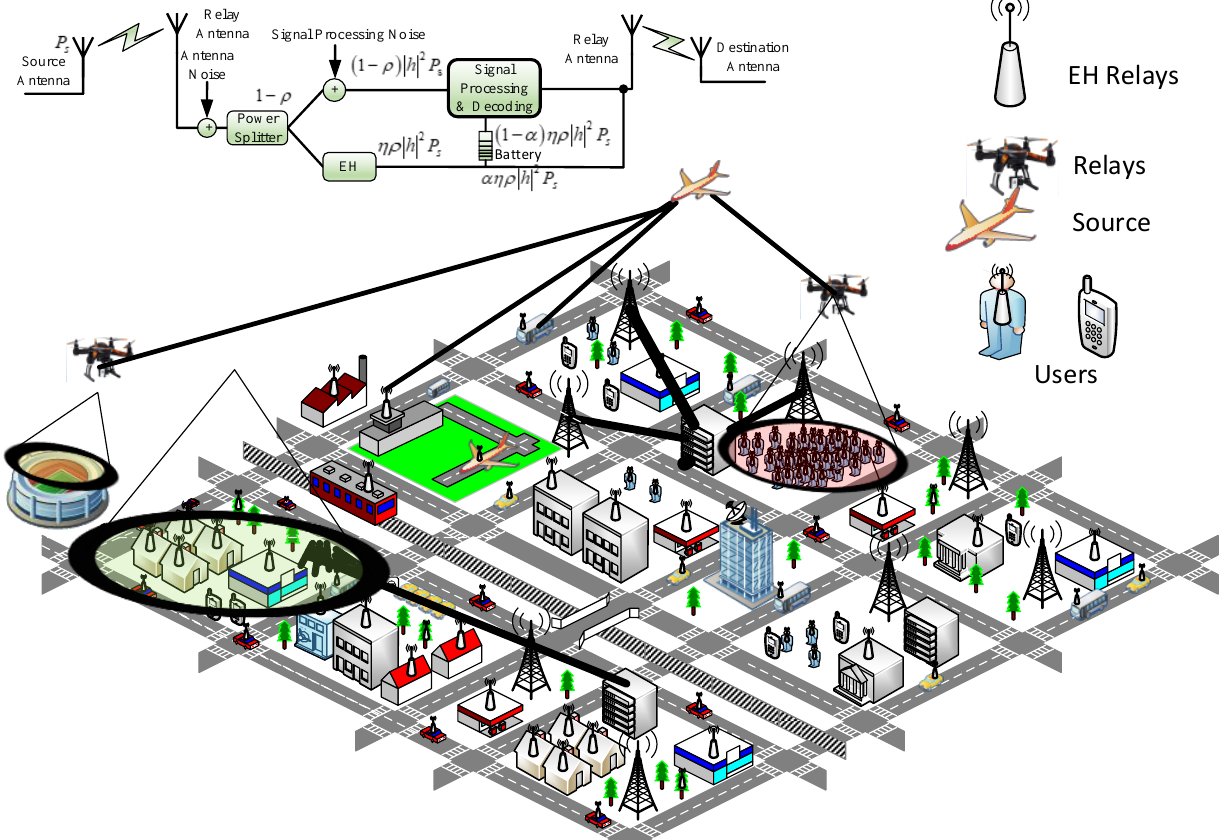
Figure 1. Example scenario of a multi-relay